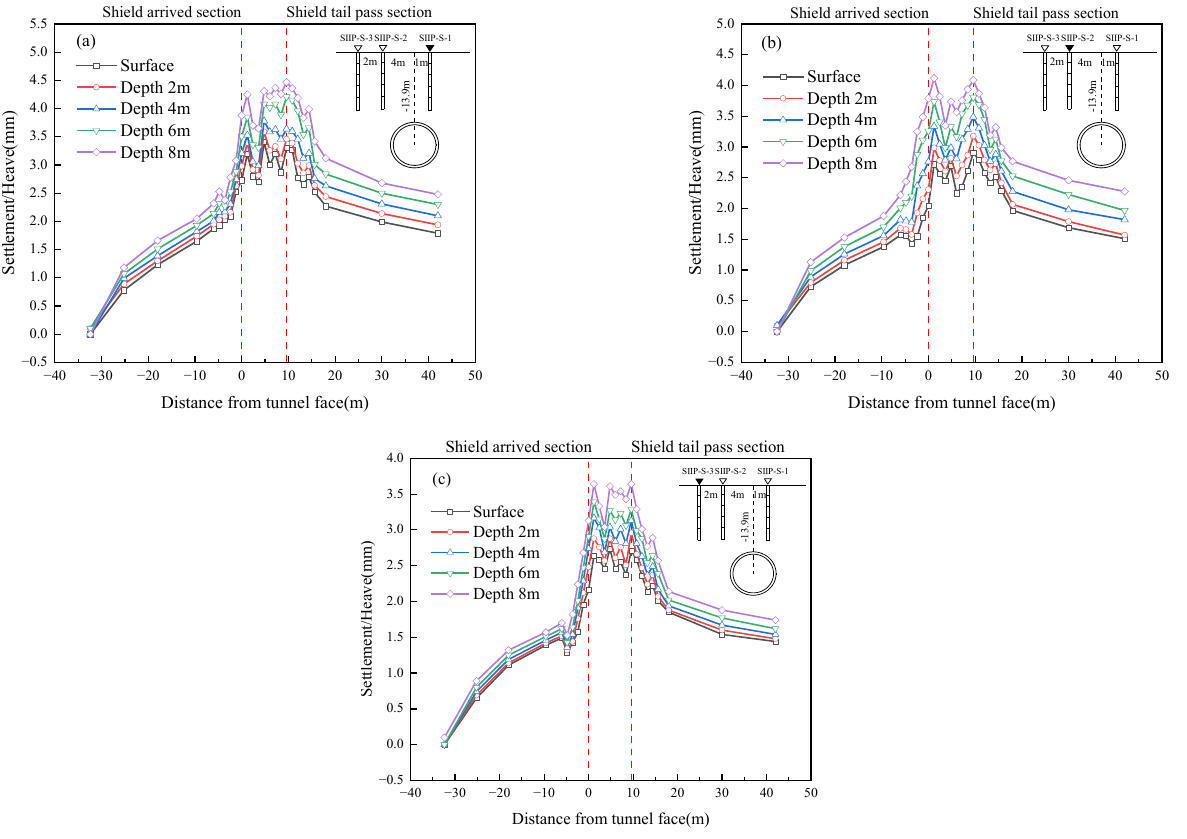
Figure 8. Vertical displacement of stratum soil in Section A: ( a ) SIIP-S-1; ( b ) SIIP-S-2; and ( c ) SIIP-S-3. Figure 9 is the time history curve of the surface vertical displacement of monitoring